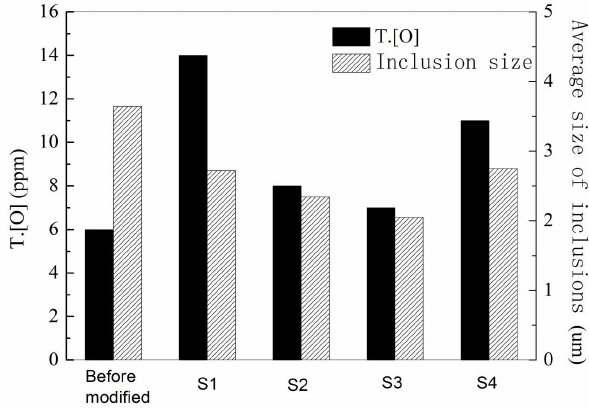
Figure 5: Variation of average diameter of inclusions and oxygen content in steel with time